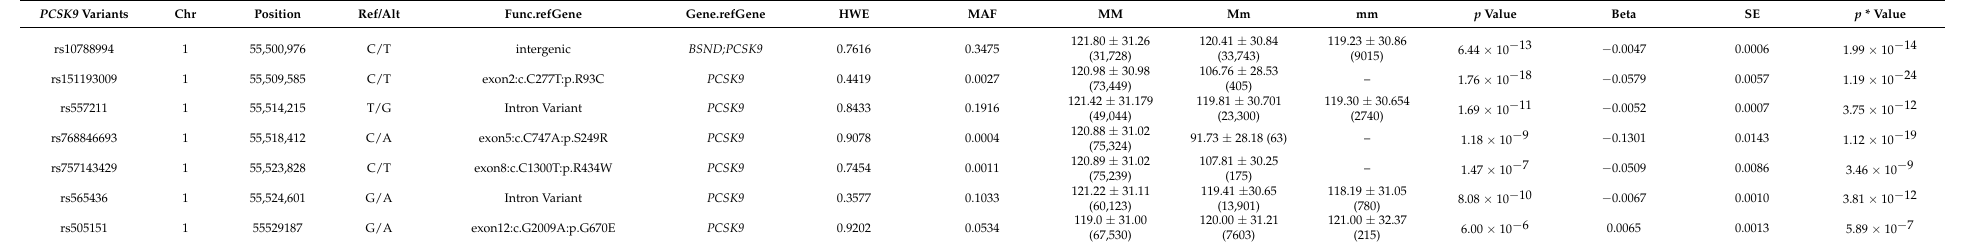
Table 1. Association between PCSK9 variants of low-density lipoprotein cholesterol (LDL-C) levels from Axiom Genome-Wide CHB 1 and 2 Array plates with genotype imputation, including common and rare PCSK9 variants.